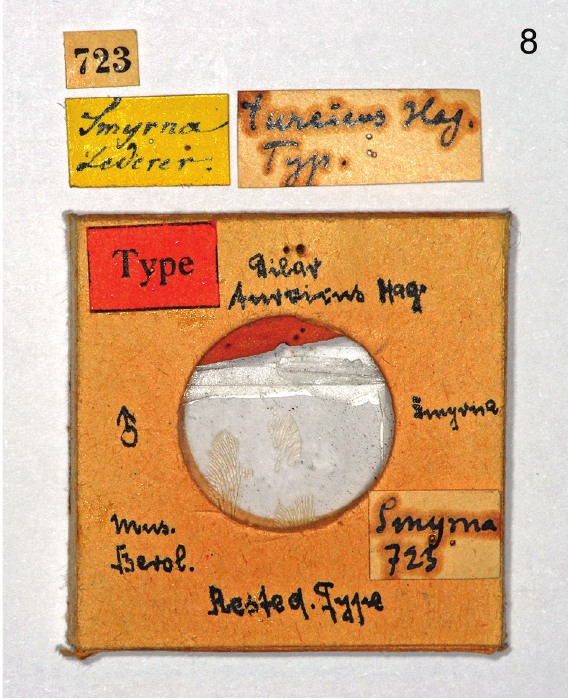
Figure 8. Dilar turcicus Hagen, syntype [now paralectotype] male (MFN, Berlin). Fragments of wings and labels.